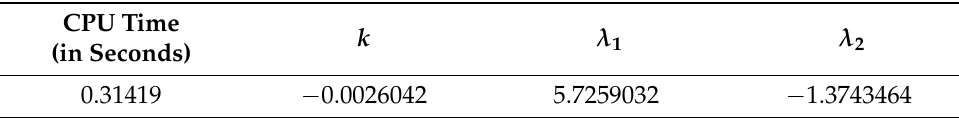
Table 1. Result of implementation of TAC (Spanish for CT scan).